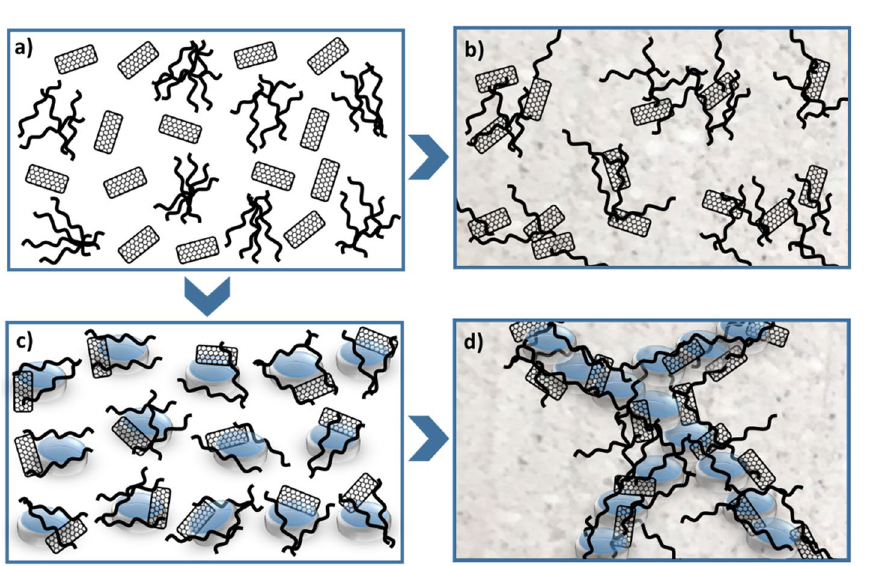
Figure 7. Schematic representation of the rGO/MWCNTs fillers spatial distribution in the mortars induced by presence/absence of natural rubber. Filler dispersion obtained without NR ( a ) and with self-assembling on NR latex particles ( b ), random filler distribution within the mortar matrix without NR ( c ) and percolated filler network assisted by NR latex particles segregation ( d